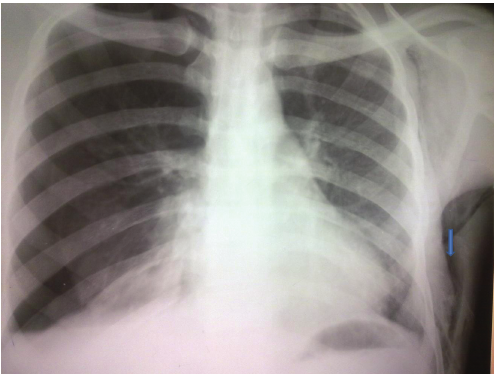
Figure 4: Subcutaneous emphysema complicating tube thoracos-